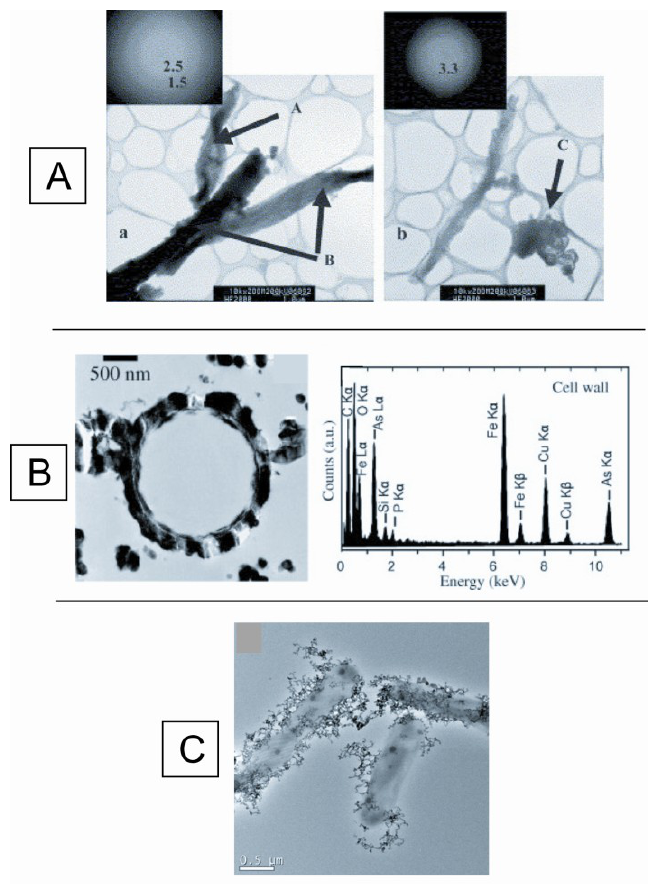
Figure 4. Examples of mineralization of bacterial cells by As-bearing